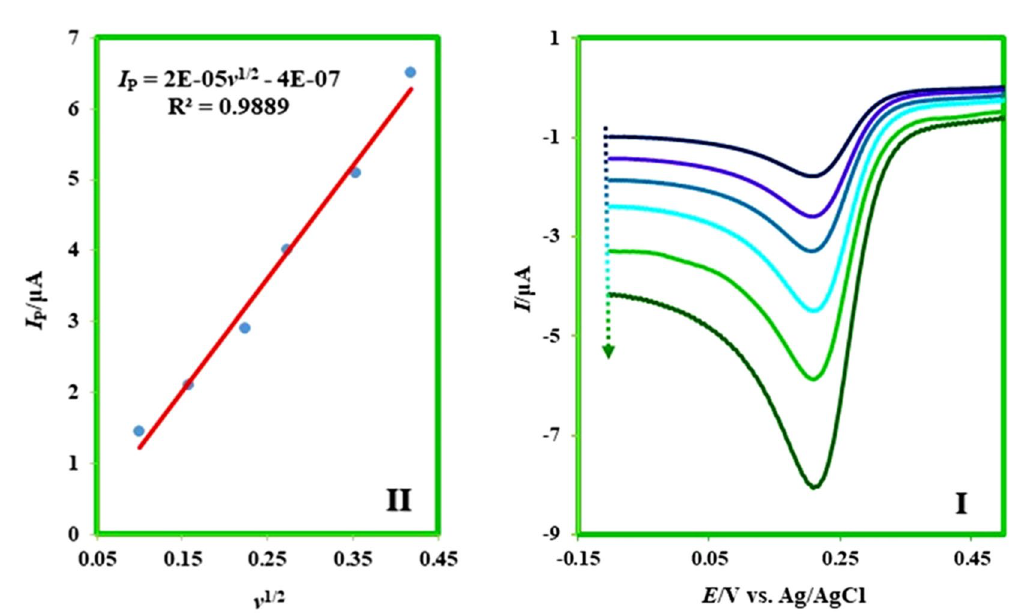
Figure 7. ( I ) Linear sweep voltammograms of 1.0 mM potassium ferricyanide containing KCl (1.0 M) at glassy carbon electrode in aqueous solution in various scan rates. Scan rates from a to f are: 10, 25, 50, 75, 125, and 175 mV/s. ( II ) I − v 1/2 diagram of curves in ( I ). Room